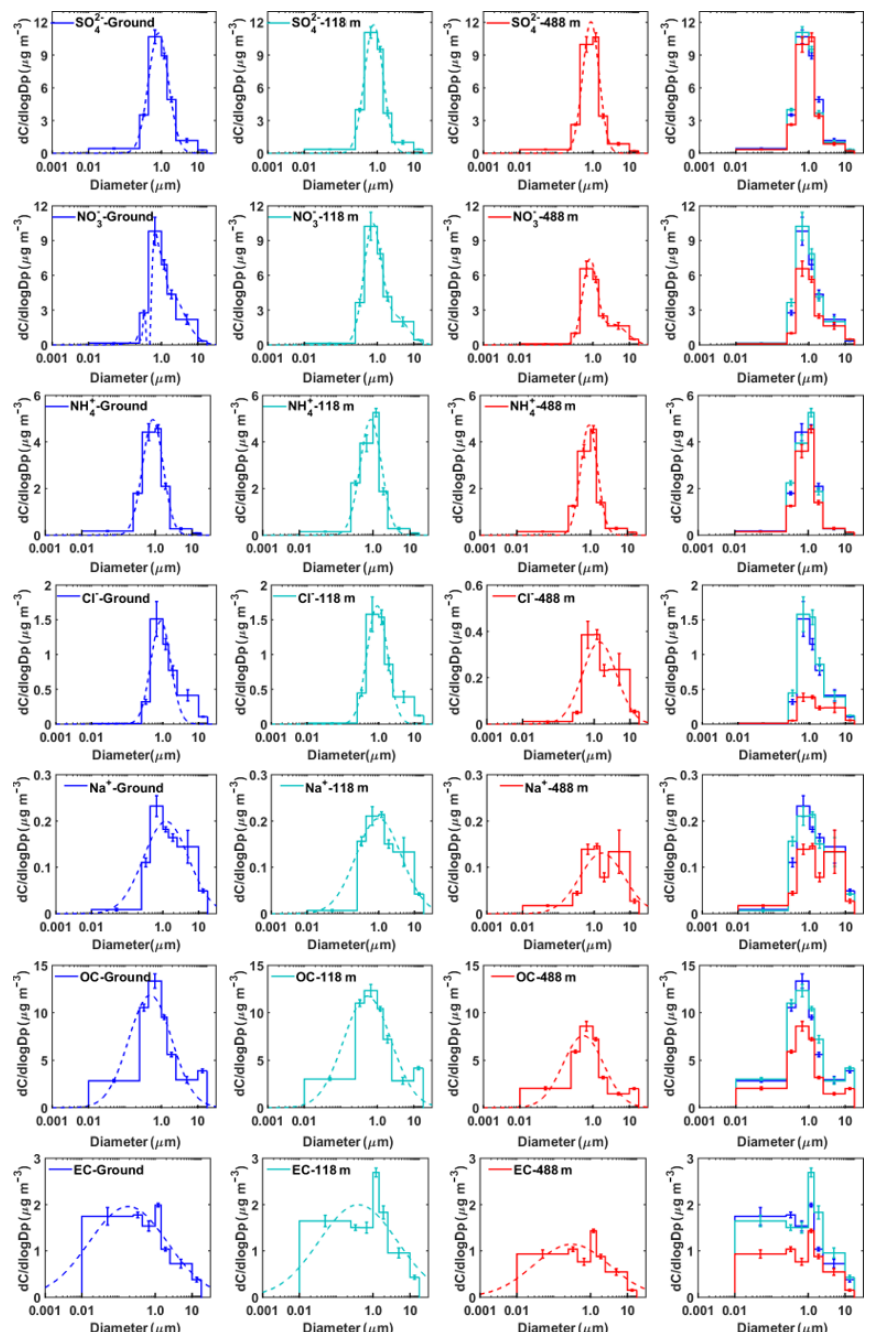
Figure 6. Mass concentration size distributions of the main chemical components measured at ground level, 118m, and 488m in winter. The dotted lines represent the nonlinear fitting of the measured average size distribution. The error bars represent the sampling and analytical standard errors for each